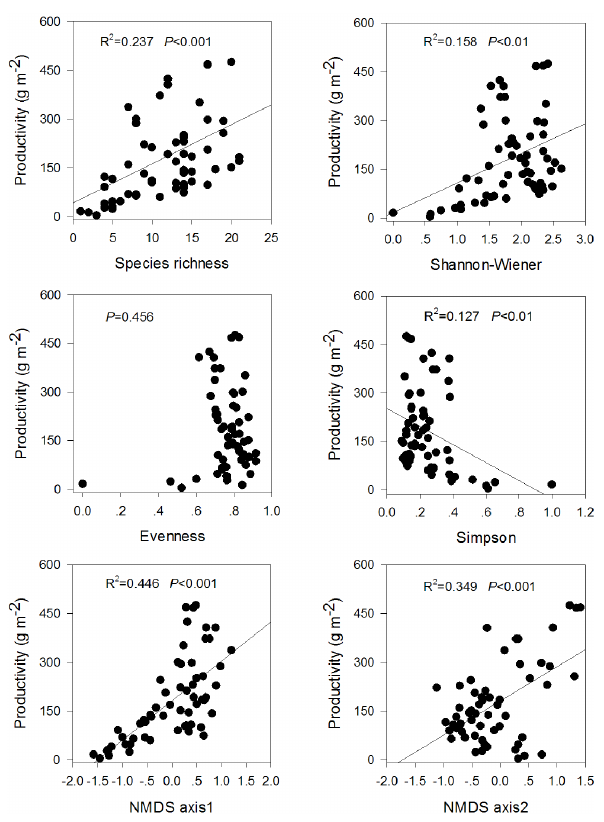
Fig.2. Relationships of different plant diversity measures and community composition to productivity in sandy grasslands (n=60). Fig.3. Structural equation modeling. a , Initial model. Single-headed arrows indicate paths. Double-headed arrows show the covariance included in the model based on modifications proposed by AMOS (procedure modification indices). The exogenous unobserved variables Err1, Err2, Err3 and Err 4 account for the unexplained error in the estimation of NMDS1, NMDS2, diversity (species richness) and productivity, respectively. Their regression weights were a priori set to unity. b , Standardized regression weights (along paths), correlations (along double-headed arrows) and squared multiple correlations (beside the boxes of NMDS1,NMDS2, diversity and productivity) for the best-fitting model D (Table 3).